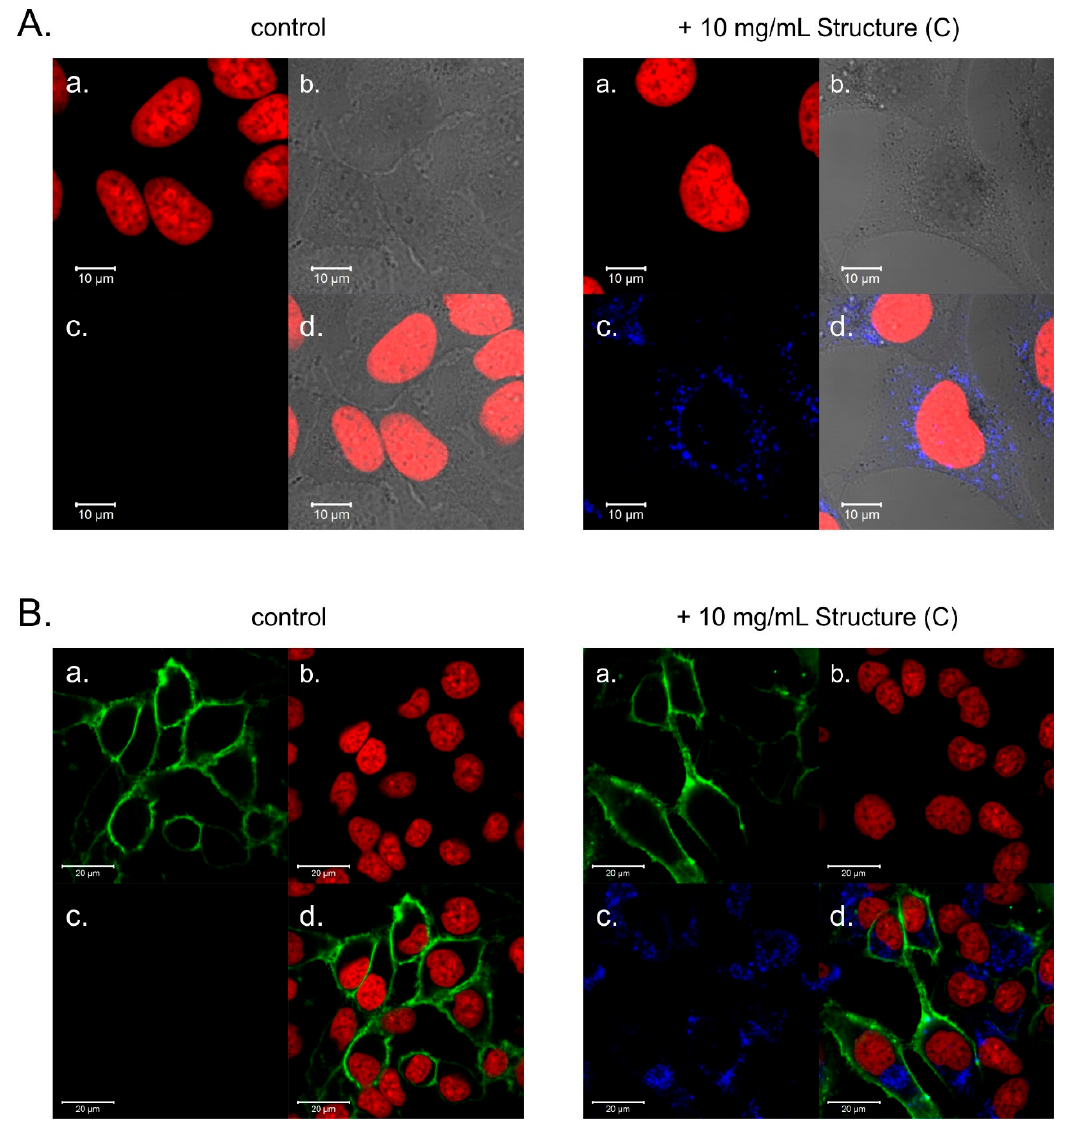
Figure 5. Representative confocal images of untreated (control) and incubated for 24 h with PAMAM [G5:G3-(TREN)]- N -(4-carbomethoxy) pyrrolidone terminated tecto(dendrimer) (C) with HeLa cells. ( A ) . Cell nuclei were stained with RedDot1. Split images represent: a. cell nuclei, b. transmitted light image, c. blue fluorescence channel (intrinsic fluorescence of PAMAM [G5:G3-(TREN)]- N -(4-carbomethoxy) pyrrolidone terminated tecto(dendrimer) (C), d. merge of a., b. and c. ( B ). Cell nuclei were stained with RedDot1; plasma membranes were stained with NeuroDiO. Split images represent: a. plasma membrane, b. cell nuclei, c. blue fluorescence channel (intrinsic fluorescence of PAMAM [G5:G3-(TREN)]- N -(4-carbomethoxy) pyrrolidone terminated tecto(dendrimer) (C), d. merge of a., b. and c.